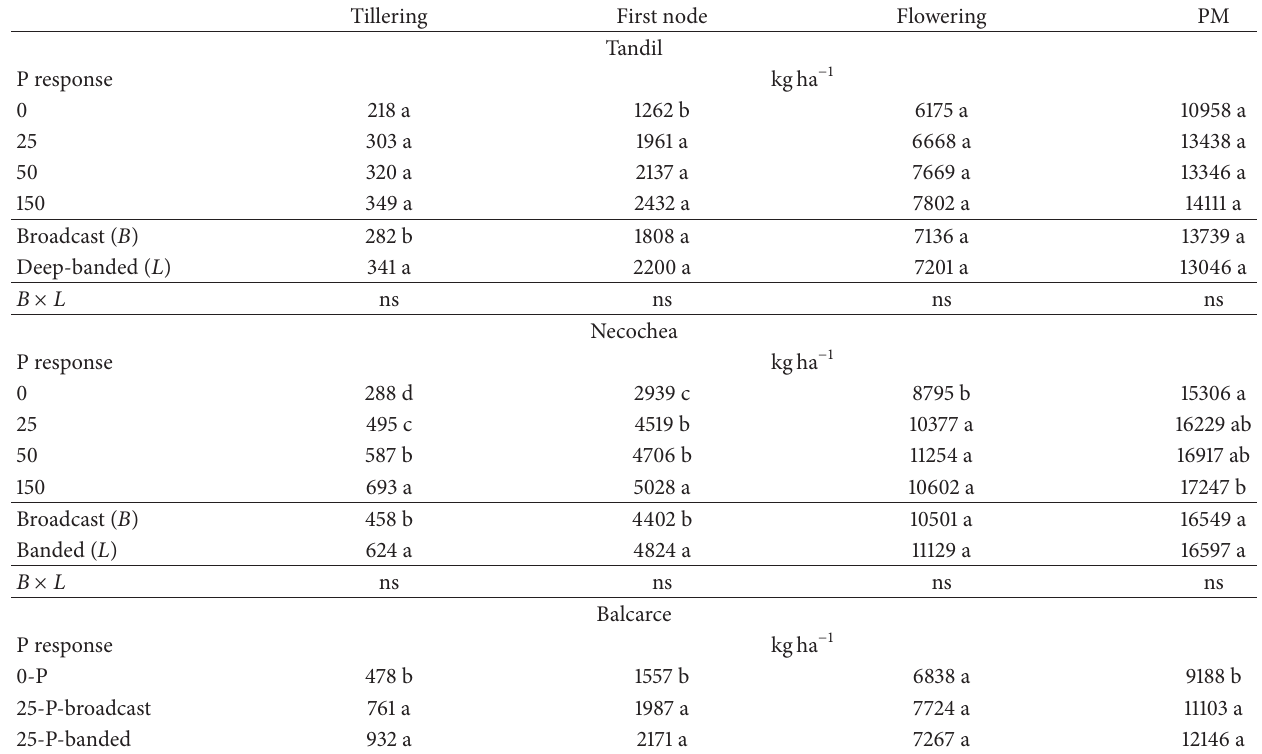
Table 3: Aerial dry matter accumulation affected by P rate and placement method at Tandil, Necochea, and Balcarce experimental sites. Tillering First node Flowering